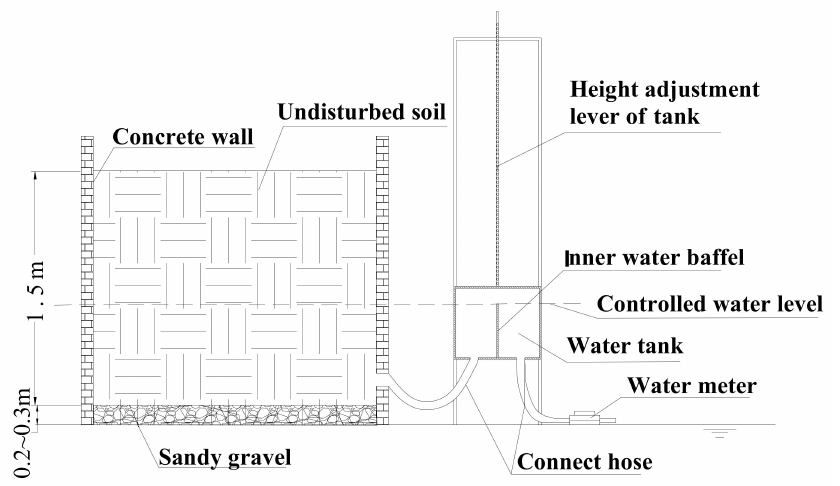
Figure 2. Schematic of the experimental test pits and the control structure.